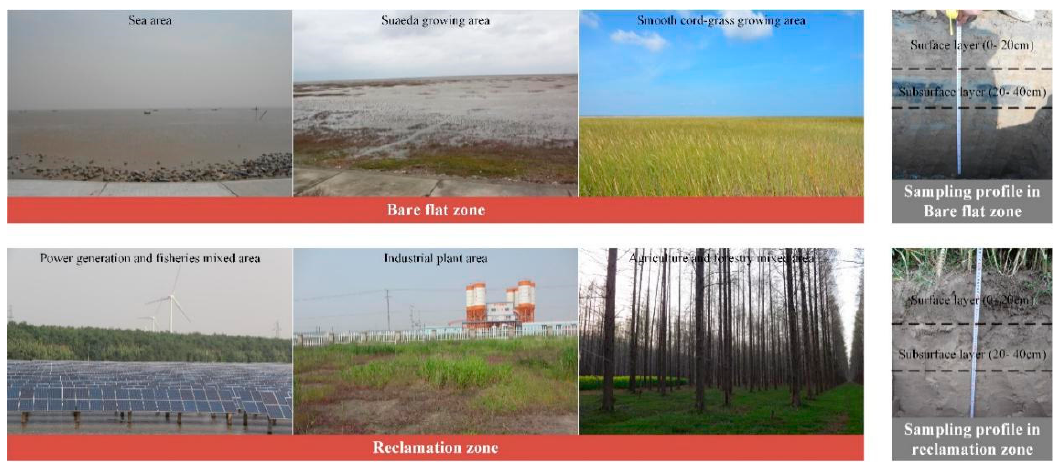
Figure 2. Typical land use and sample profile in the study area.